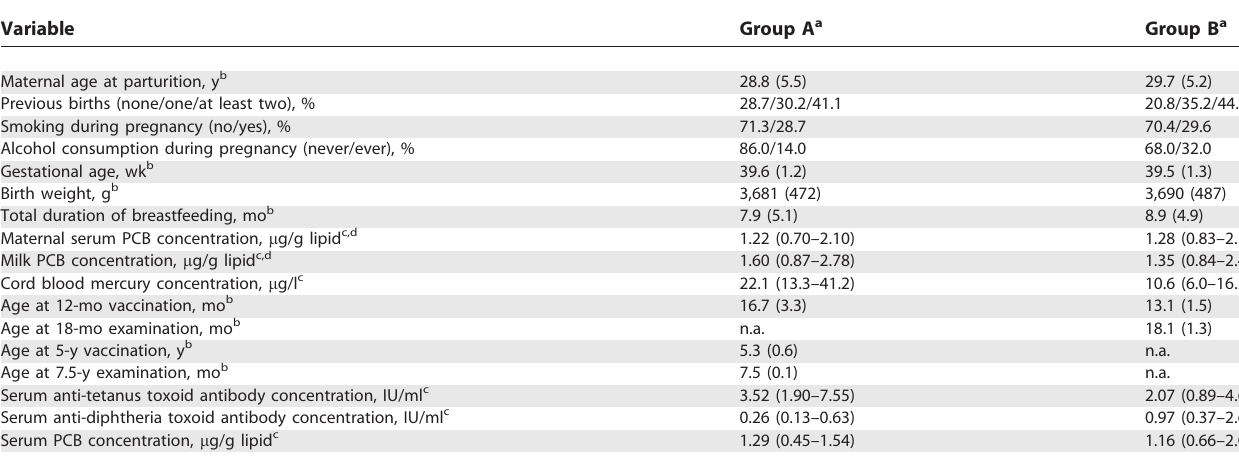
Table 1. Characteristics of Two Faroese Birth Cohorts Examined at Ages 7.5 y and 18 mo